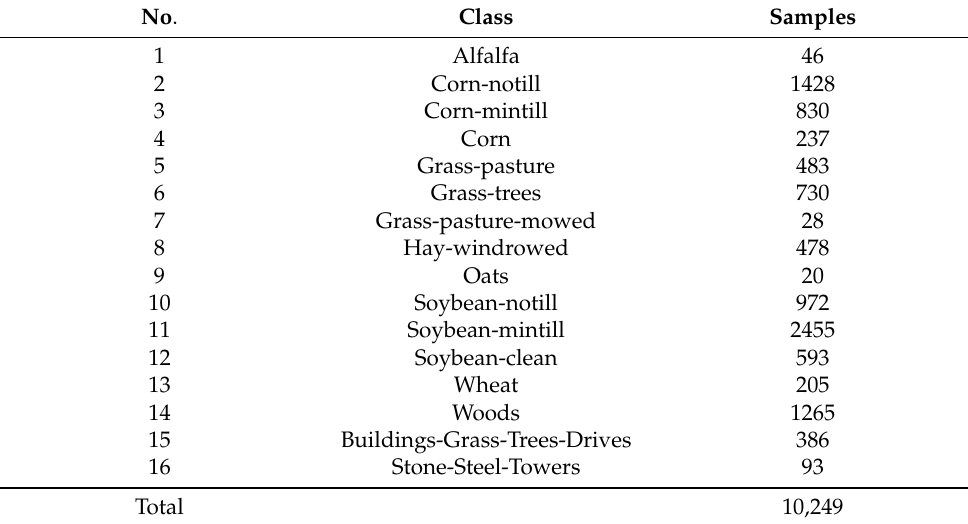
Table 5. The classes’ names and the number of sample for the Indian Pine